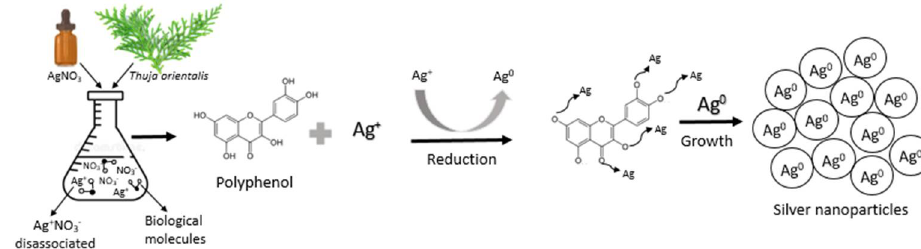
Figure 2. Schematic representation for green synthesis of silver nanoparticles with Thuja orientalis . Adapted from [3,46,47].